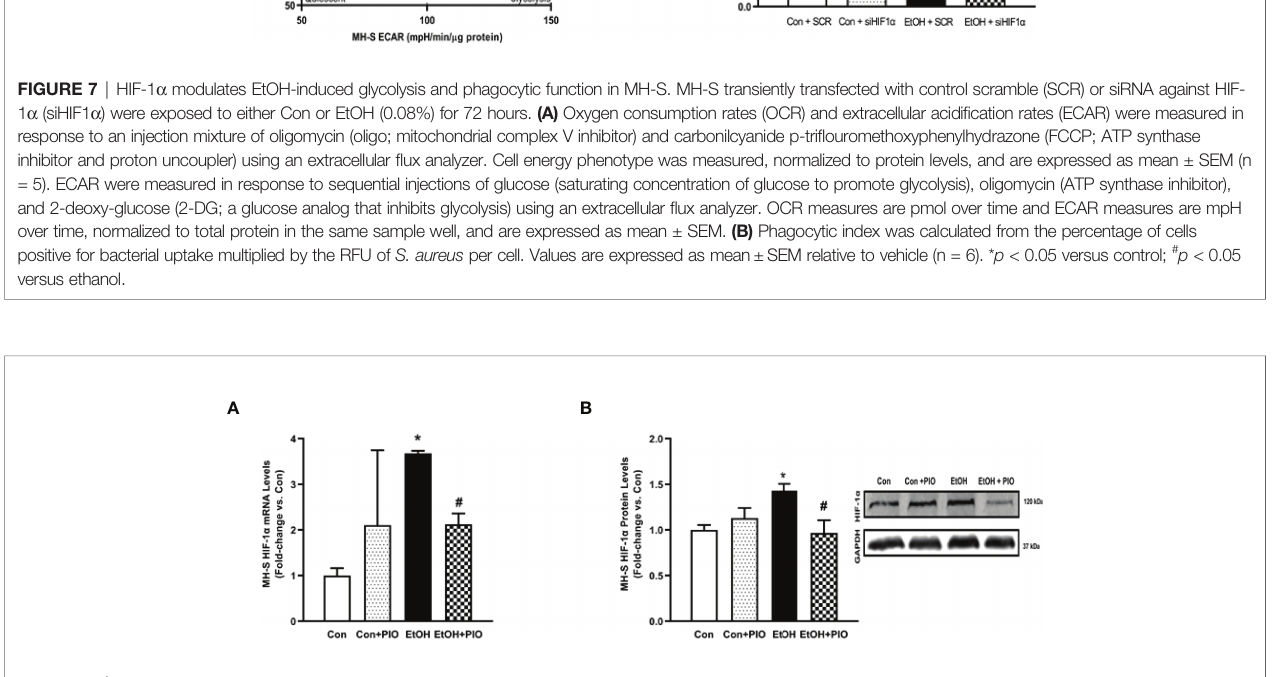
FIGURE 8 | Pioglitazone treatment reverses EtOH-induced HIF-1 a levels. MH-S exposed to either control (Con) or ethanol (EtOH; 0.08%) for 72 hours ± pioglitazone (PIO; 10 m M, last 24 hours of EtOH exposure). (A) HIF-1 a mRNA levels were measured by qRT-PCR, in triplicate, normalized to GAPDH, and expressed as mean±SEM, relative to control (n = 3). * p < 0.05 versus control; # p < 0.05 versus EtOH. (B) HIF-1 a protein levels were evaluated via western blot, normalized to GAPDH protein, and densitometry is expressed as mean±SEM, relative to control (n = 3). Representative western blot images have been provided. *p < 0.05 versus control; # p < 0.05 versus